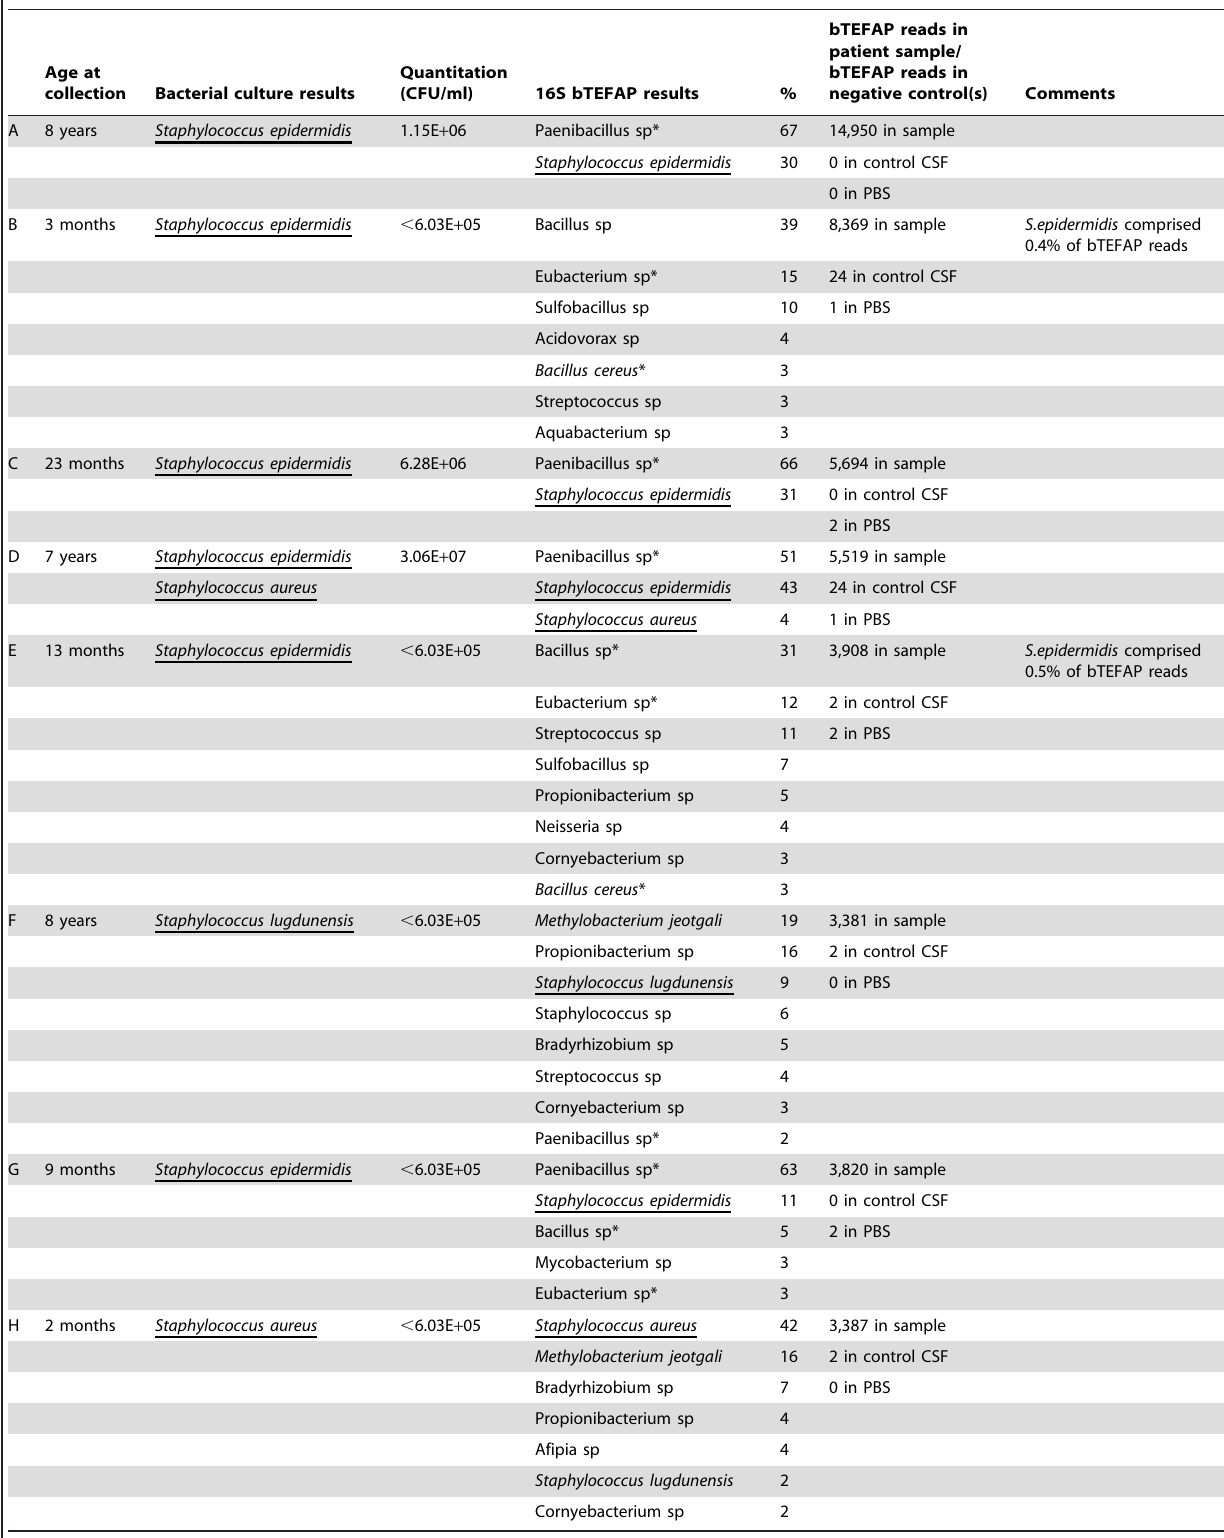
Results for 8 initial CSF samples from 8 subjects are reported. For the bTEFAP results, only bacteria comprising 2% or more of reads in a sample are presented, with exceptions noted in the comments column. Underlined font indicates an organism was detected with both testing methods. *indicates a bacterium is an anaerobe; there were no attempts to culture obligate anaerobes. doi:10.1371/journal.pone.0083229.t001 PLOS ONE |